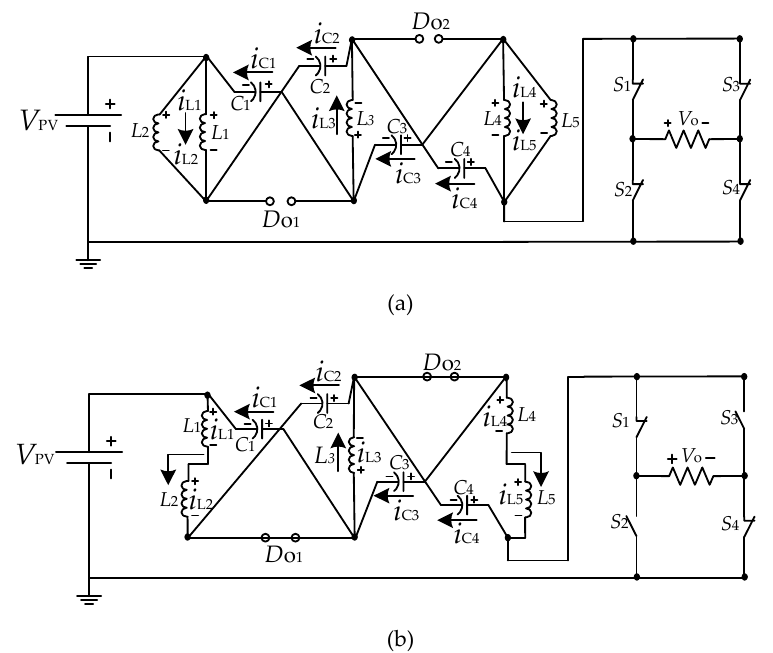
Figure 3. Equivalent circuits of the SL-SBZSI: ( a ) shoot-through state and ( b ) normal pulse width modulation (PWM) state.